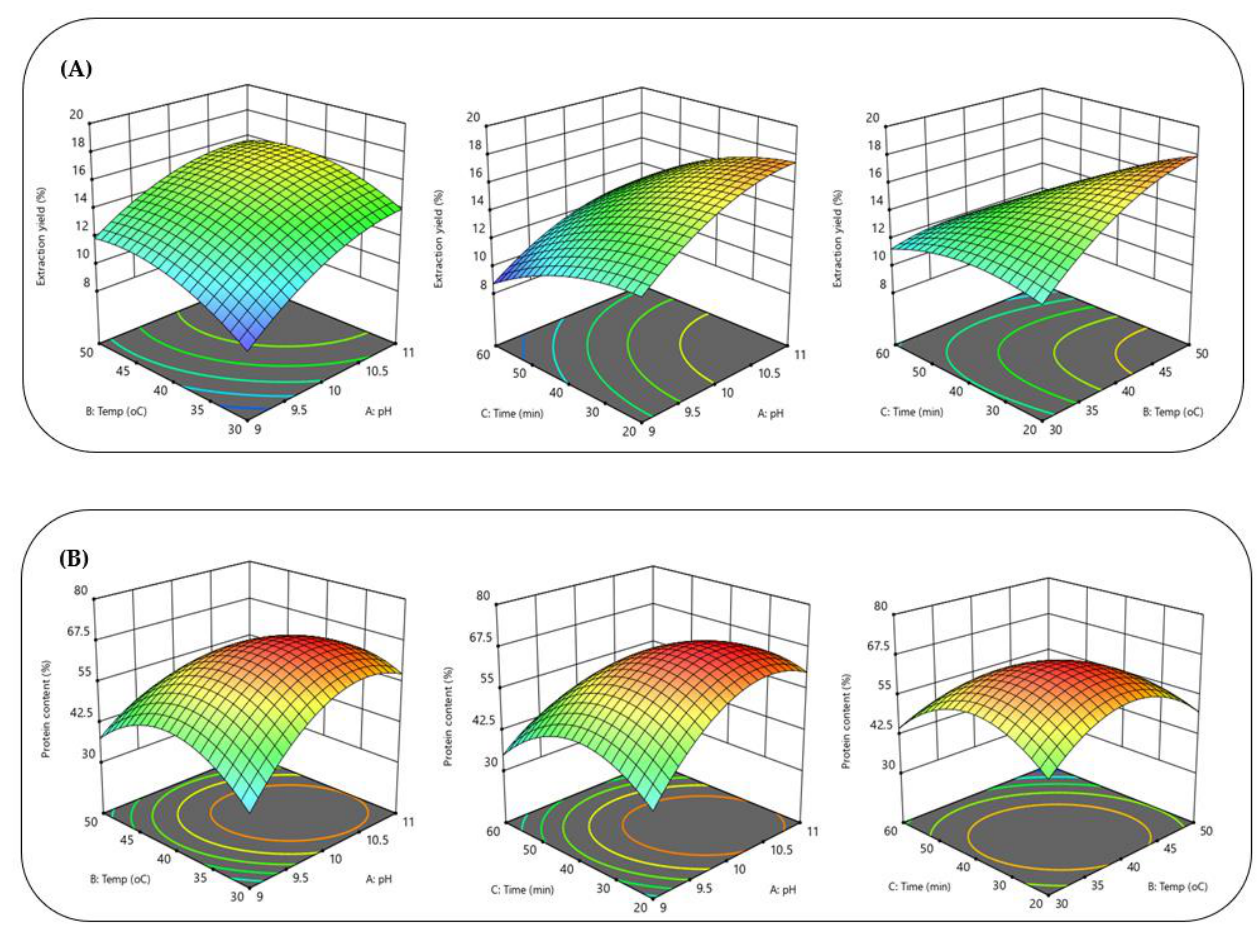
Figure 2. Response surface plots representing the effect of ultrasound-assisted alkaline-extraction conditions on the ( A ) extraction yield and ( B ) protein content of cherimoya-seed protein concentrate.